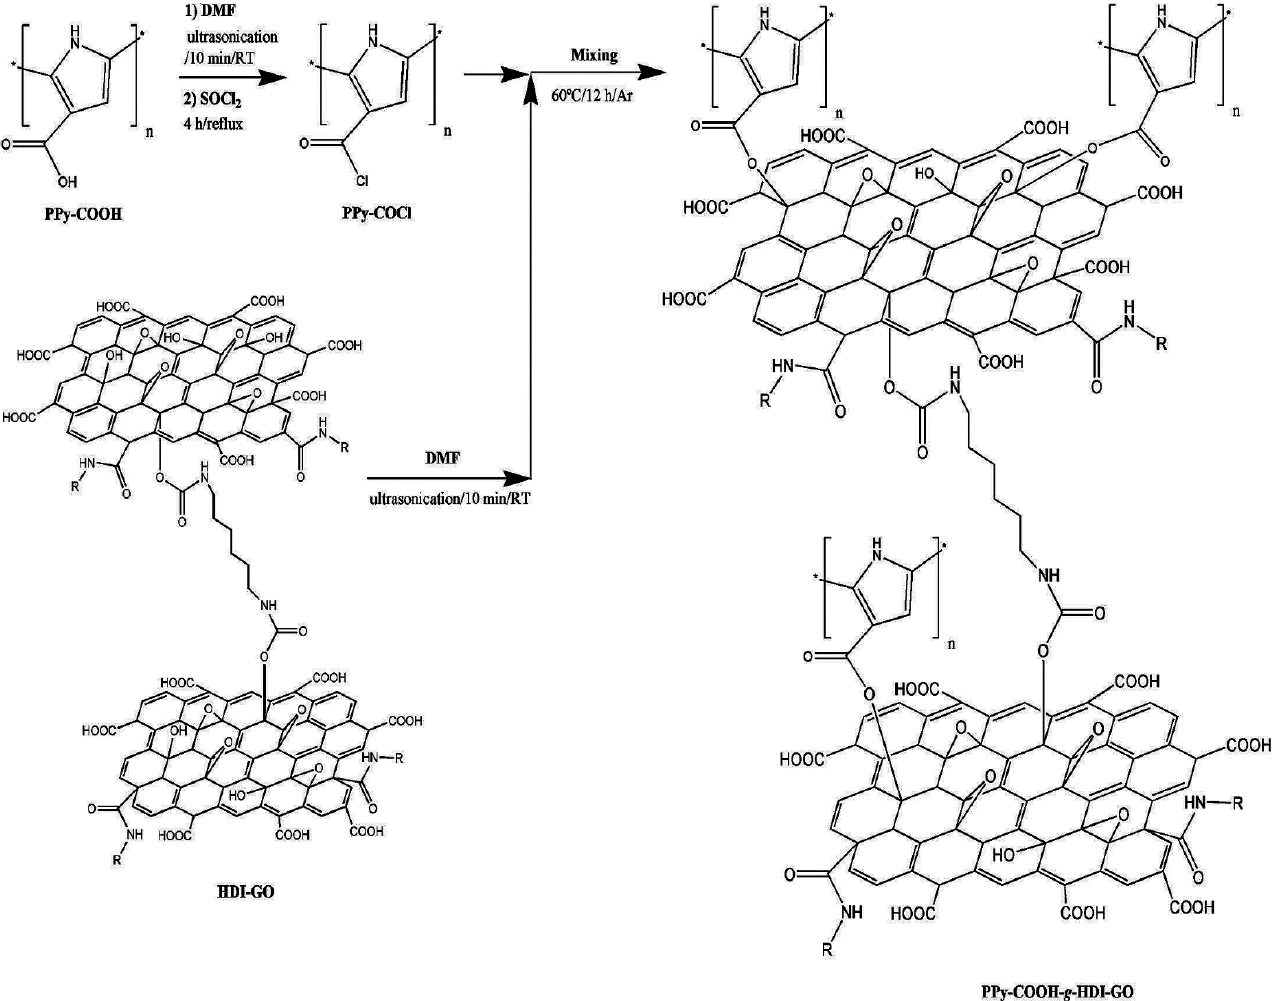
Scheme 11. Representation of the synthesis of polypyrrole-carboxylic acid derivative (PPy-COOH) covalently anchored on hexamethylene diisocyanate (HDI)-modified graphene oxide via esterification reaction with previous functionalization of the carboxylic groups with SOCl 2 . Taken from [56].